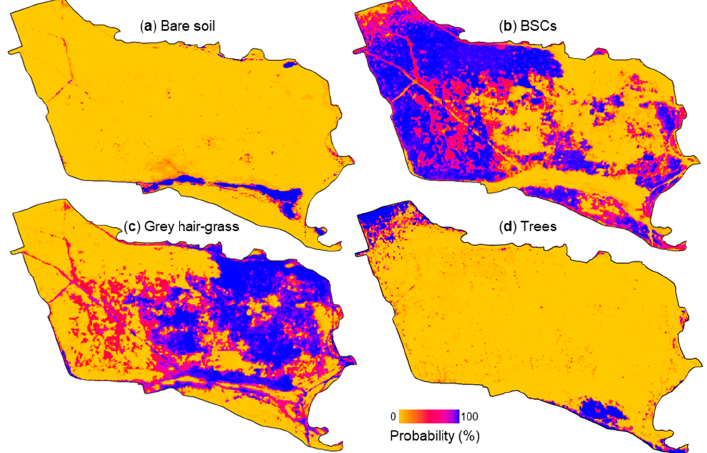
Figure 6. Probability for each pixel within the study area to be assigned to the respective dominant land cover as determined by the Random Forest classification model: for the class ‘bare soil’ ( a ); for the class ‘biological soil crusts’ (BSCs) ( b ); for the class ‘grey hair-grass’ ( c ); and for the class ‘trees’ ( d ). The individual probabilities add up to 100%. The spatial resolution of the maps is 10 m.